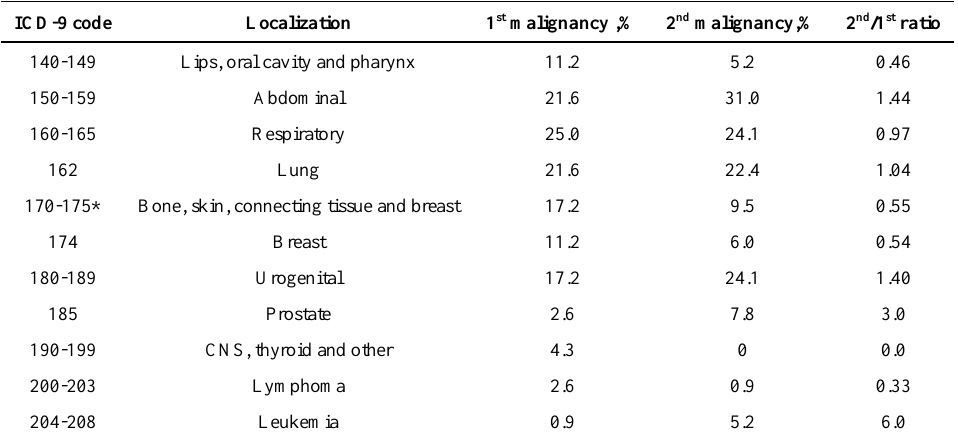
Table 3. Cancer incidence in the study cohort by ICD-9